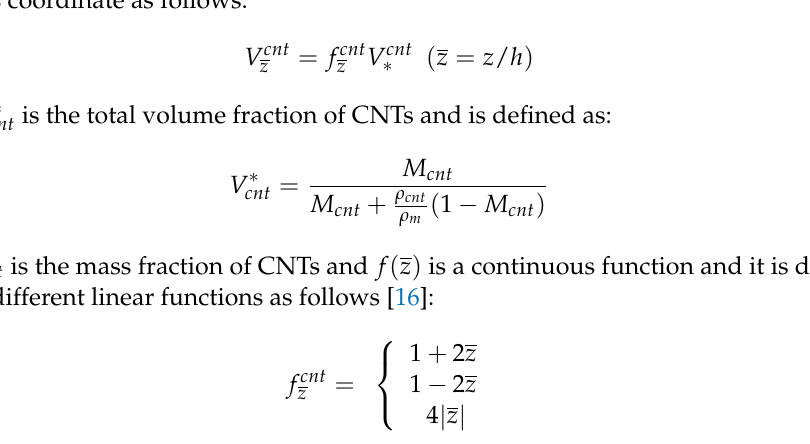
Figure 2. CNT patterned construction elements: ( a ) spherical shell, ( b ) hypar shell, ( c ) cylindrical panel and ( d ) rectangular plate.